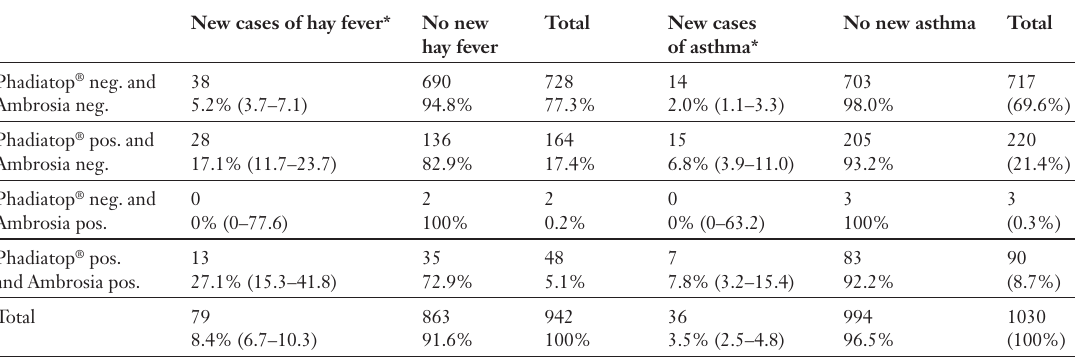
* Absolute frequency and row percentage (with 95% confidence interval in parentheses)